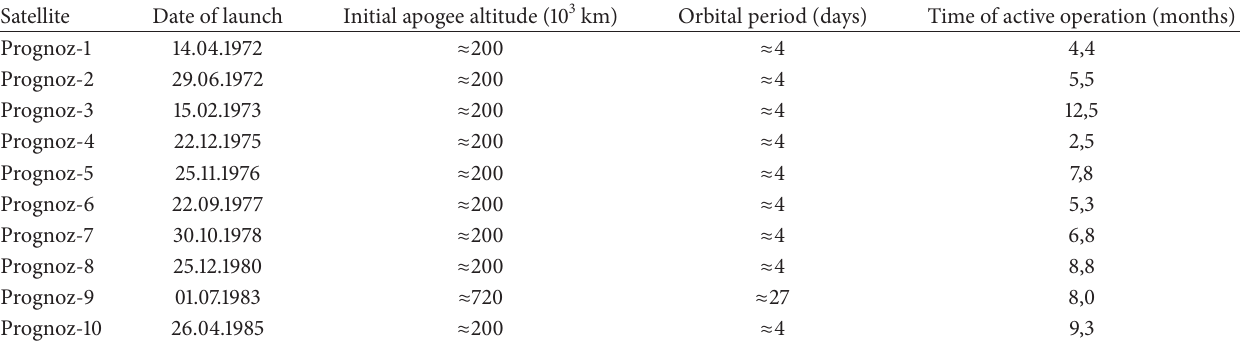
Table 2: Dates of launch and orbits of the satellites Prognoz—measurements out of the